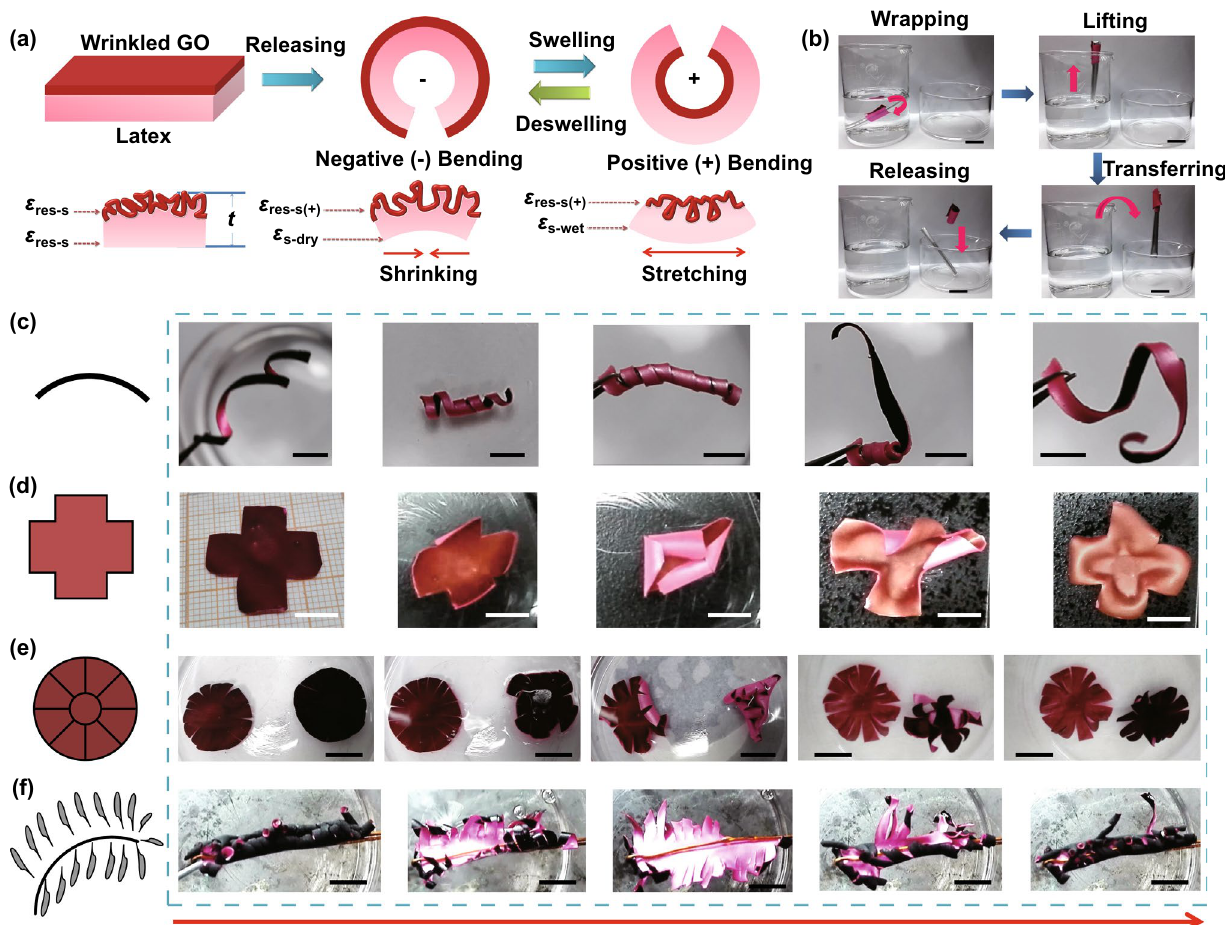
Fig. 17 Typical application cases of the wrinkled GO/latex bilayer actuators. a Schematic illustration of the mechanical self-assembly of the bilayer actuators. When the wrinkled GO/latex bilayer sphere is cut into slices, the obtained bilayer sheets bend spontaneously to partially release the residual stress stored in the system, which can also bend backward in response to some organic solvents, and could recover to its ini- tial bending state after drying in air. b A bilayer actuator used as a mechanical hand grasping cylindrical Al foil in n -hexane. c – f Digital images of the bending and recover process of c a worm-like swimmer, d a smart package, e two bionic flowers, and f a bionic mimosa. All scale bars in the images are 1 cm [55]. Copyright 2017 American Chemical